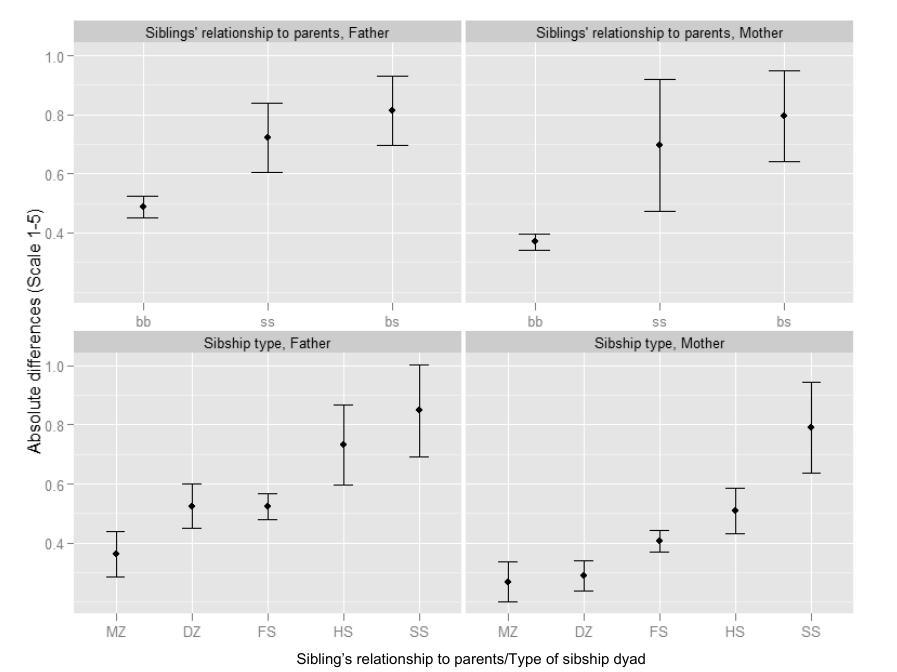
Fig. 1: Absolute difference in relationship assessments between siblings, by type of sibling dyad, parent-child relationship status, and sex of